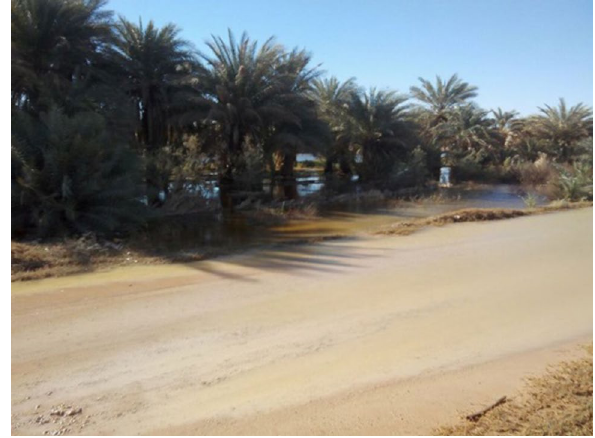
Fig. 16 Aerial view of the Kesibat Sebkha flood. (photo. Authors 2018)